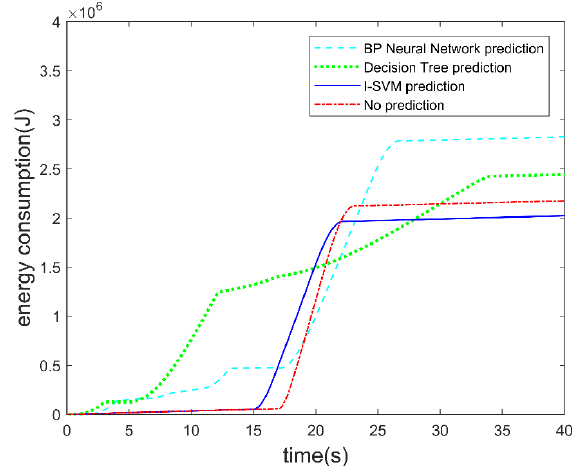
Figure 12. Energy consumption of the autonomous vehicle.